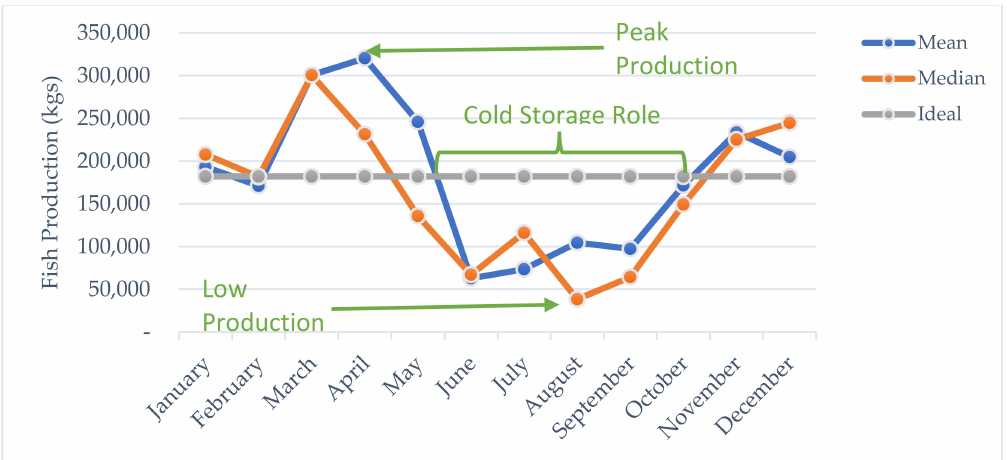
Figure 3. Central Tendency and Ideal Pattern Fish Production per month [28].